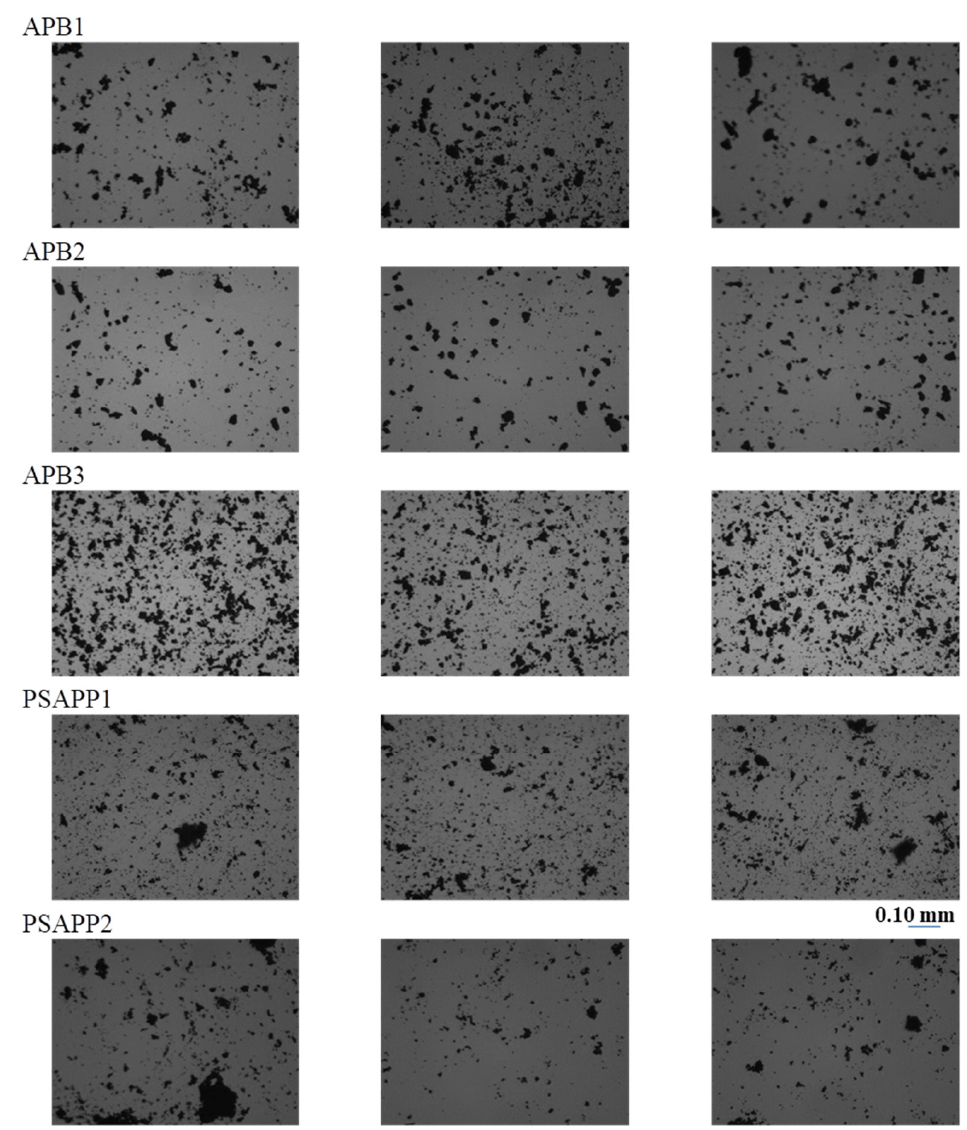
Figure 3. Photomicrographs of the three selected areas for each sample, under transmitted light at 160× magnification.